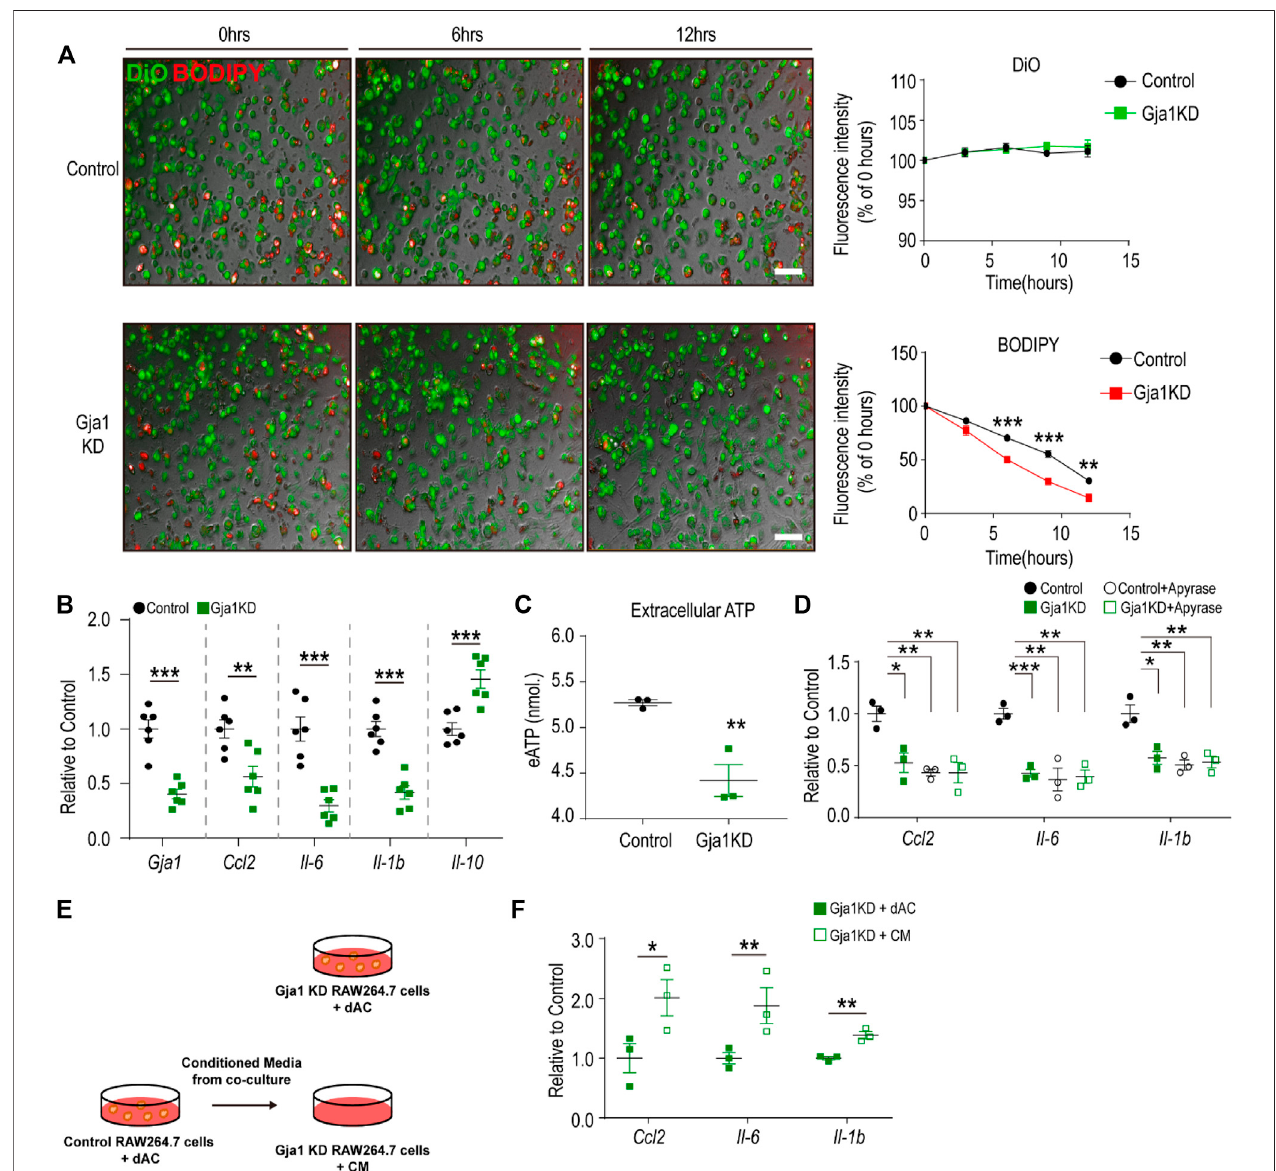
FIGURE3| Cx43knockdownreducesin fl ammatoryresponsesofmacrophagesco-culturedwithdyingadipocytes (A) LiveimagingofRAW264.7cellstransfected with Gja1 siRNAorcontrolsandco-culturedwithdyingadipocytes(dACs)for12 h.AdipocytesweretaggedwithC12-BODIPY(red)andmacrophageswerestainedwith DiO (Green) ( n = 3) (B) qPCR analysis of Gja1 and in fl ammatory cytokine markers in RAW264.7 cells transfected with Gja1 siRNA or controls and co-cultured with dACs for24 h( n =6) (C) ExtracellularATPlevelinlipopolysaccharide(LPS)-stimulatedRAW264.7macrophages treatedwith Gja1 siRNA orcontrolfor30 min( n =3) (D) qPCR analysis of in fl ammatory cytokines in RAW264.7 cells transfected with Gja1 siRNA or controls, and co-cultured with dACs in the presence or absence of apyrase (2U/ml) ( n = 3) (E) Schematic diagram illustrating the experimental method used for F. Conditioned media obtained from control RAW264.7 cells co-cultured with dACs were transferred into Gja1 KD RAW264.7 cells (F) qPCR analysis of in fl ammatory cytokine markers in Gja1 KD RAW264.7 cells co-cultured with dACs (GjaKD + dAC) or exposedtotheconditionedmediaobtainedfromthecontrolco-cultures(Gja1KD+CM)( n =3).Unpaired,two-tailedt-tests(* p < 0.1,** p < 0.01,*** p < 0.001).Eachpoint represents biological replicate. Data are presented as mean ±